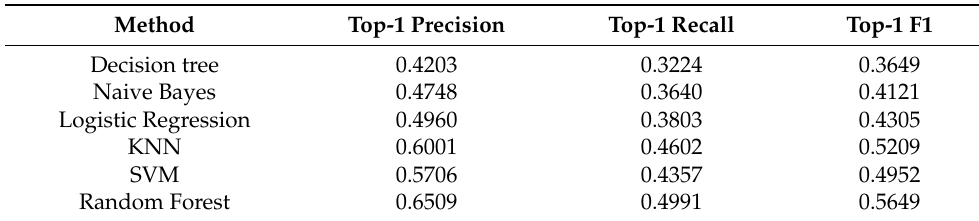
Table 1. Ten-fold cross validation performance in CV-Type by different classifiers based on HMDD v3.2.